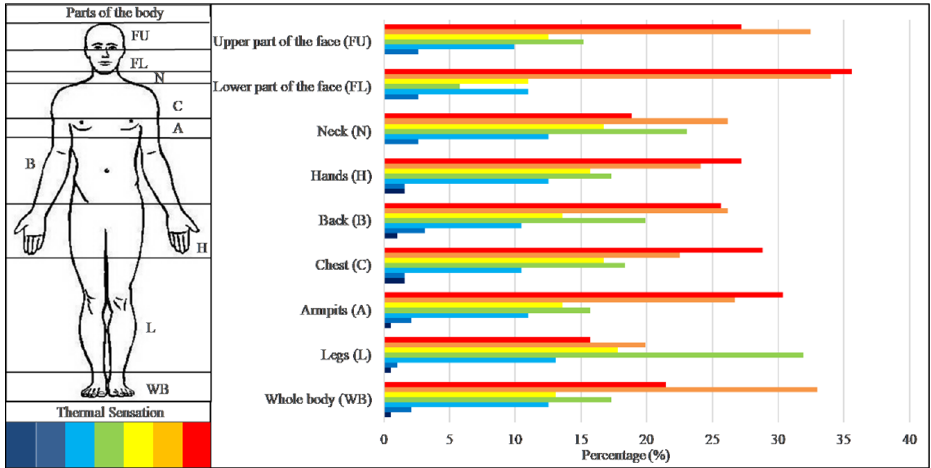
Figure 2. Thermal sensations declared by healthcare workers for each parts of the body covered by PPE during working time. Dark blue: Very cold; Blue: Cold; Light blue: Slightly cold; Green: Neutral; Yellow: Slightly hot; Orange: Hot; Red: Very hot. The lower face part was the body area for which the greatest number of HCW (35.6%)